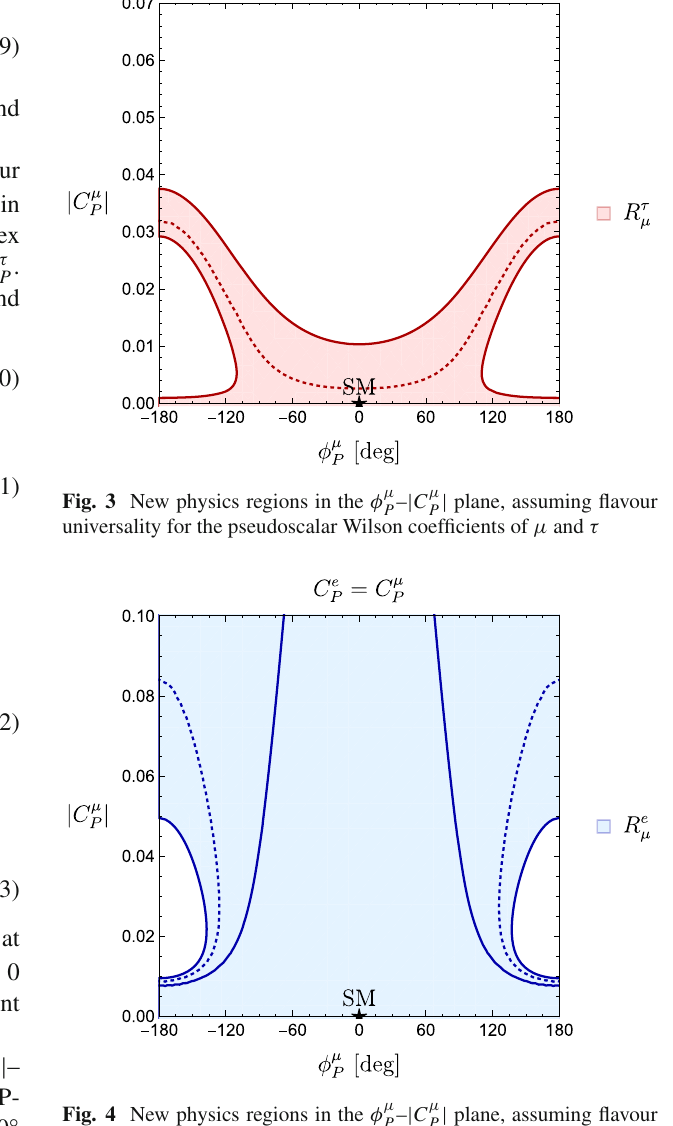
μ μ | plane, assuming – | C P P